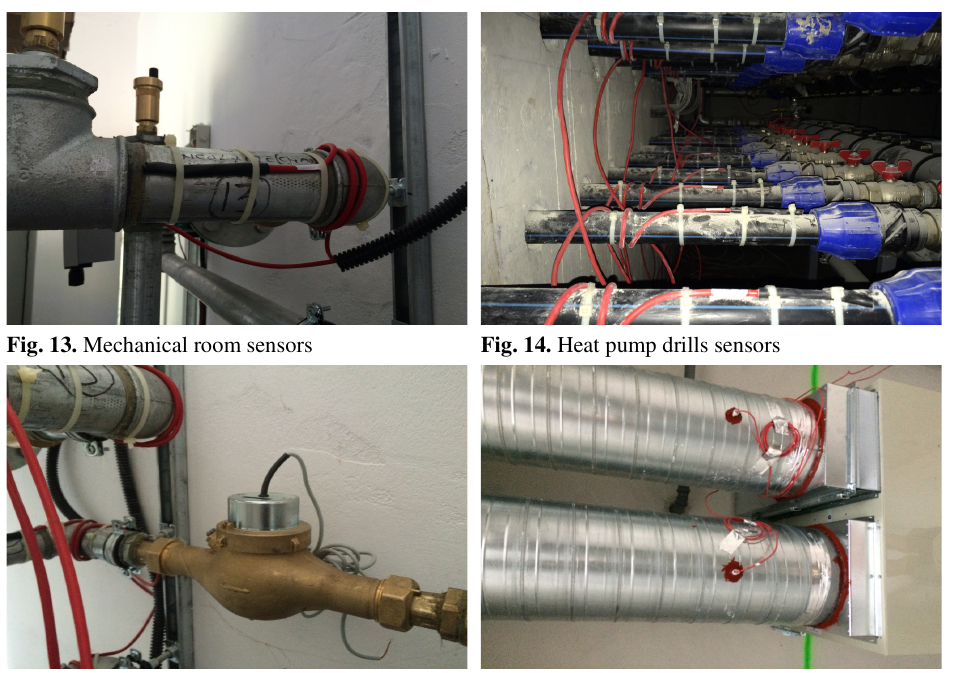
Fig. 13. Mechanical room sensors Fig. 14. Heat pump drills sensors